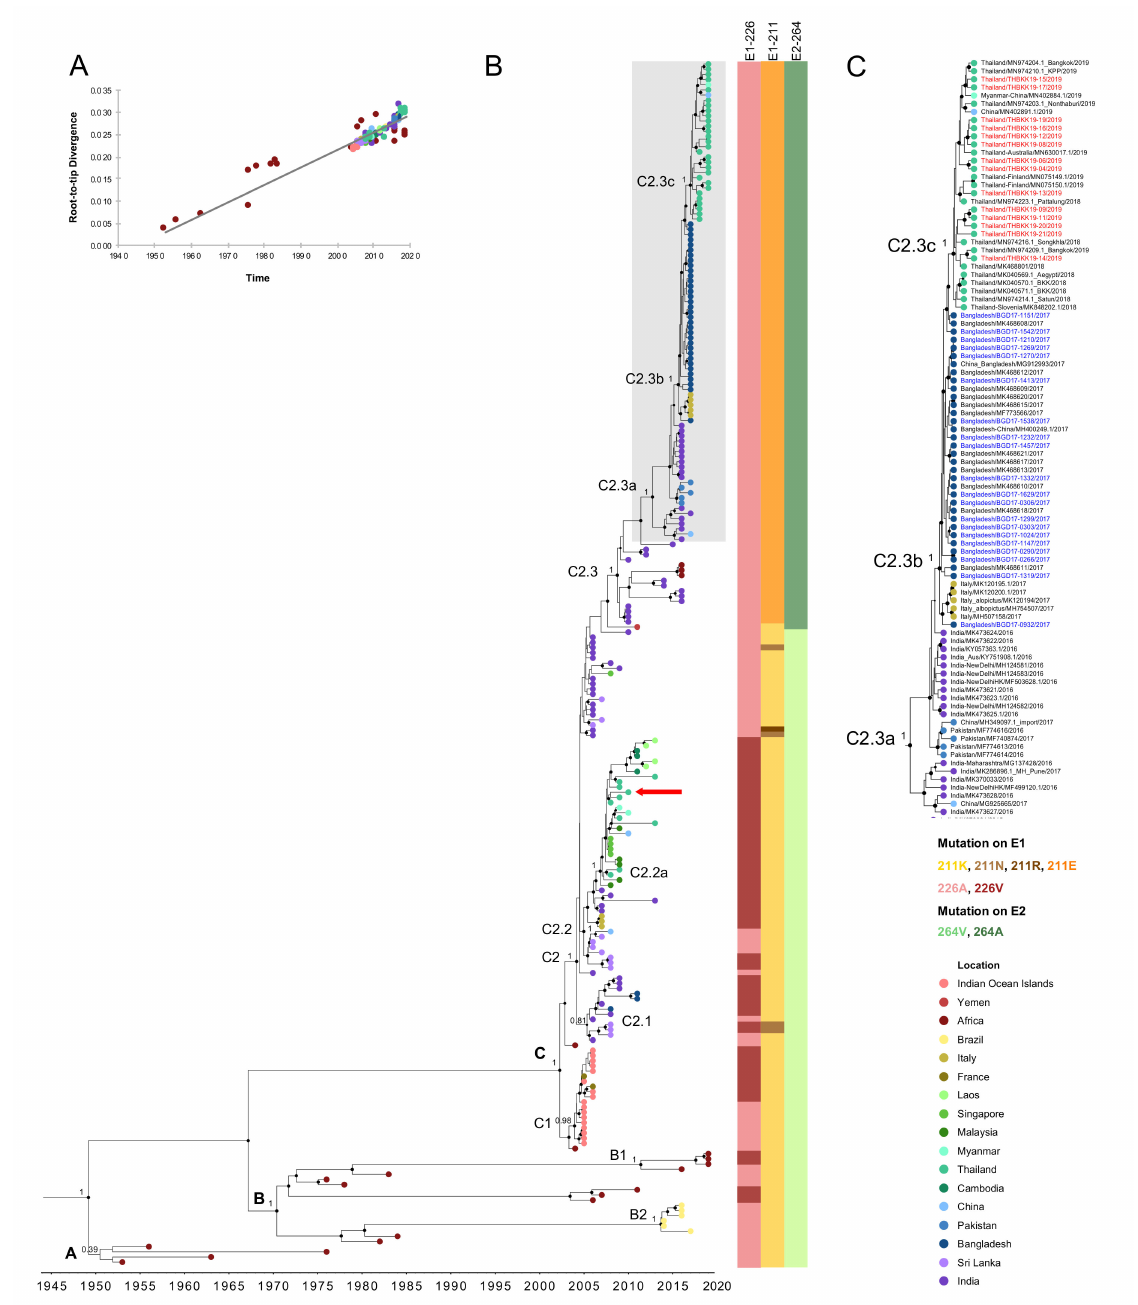
Figure 3. Molecular clock analysis of ECSA-genotype CHIKV. ( A ) Temporal signal analysis of regression of root-to-tip divergence against date. The color marker represents the location indicated in the left panel. ( B ) Maximum clade credibility (MCC) tree of East / Central / South African (ECSA)-genotype CHIKV ORFs. The timescale in years is shown in the x -axis at the bottom. Black nodes are shown only for those with the posterior probability (PP) more than 0.8. Yellow triangles indicate the key nodes, and PP values are shown adjacent to the corresponding key nodes. CP10 is shown by a red arrow. The round tip color of each sequence corresponds to the location indicated in panel C. ( C ) Magnification of a gray-shaded area in B including recent India, Bangladesh, and Thailand clades. The Bangladesh and Thailand sequences obtained in the present study are labeled with blue and red, respectively. Sequences are designated in the format of country / accession number / year of collection. The amino acid mutations specific to the Indian Ocean Lineage (IOL) correspond to their sequences shown next to the sequence tip of the MCC tree in panel B and indicated in the right